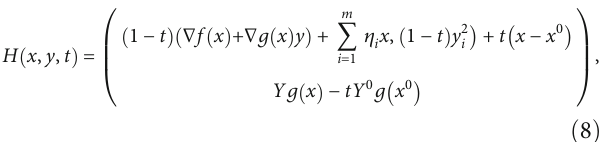
Figure 1: The set Ω = f x ∈ R 2 ∣− ð x ≤ 0, x − 3 ≤ 0 g 1